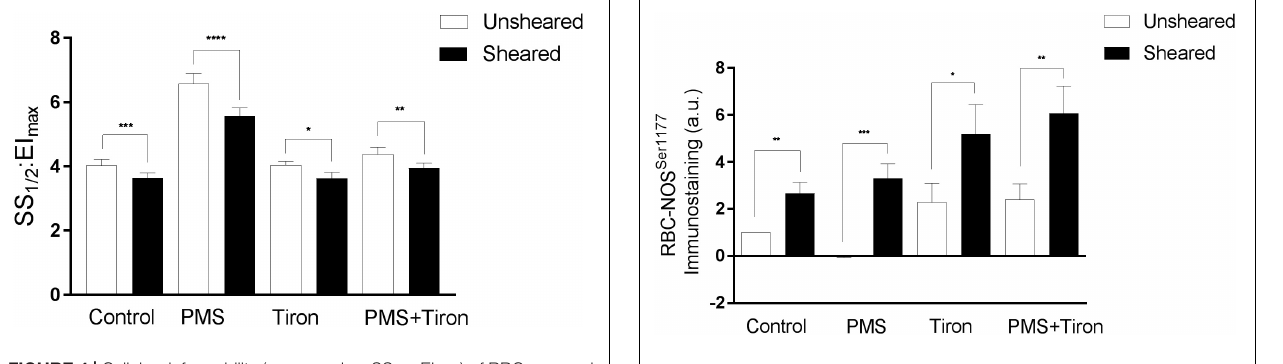
FIGURE 5 | Relative density of immunostained RBC for RBC-NOS Ser 1177 ; results reported as relative change in density compared to Control RBC. Significantly different between designated pairing at ∗∗∗ p < 0.001, ∗∗ p < 0.01, or ∗ p < 0.05. duration-magnitude combinations utilized in ektacytometry and for 300 s; Supplementary Figure 1